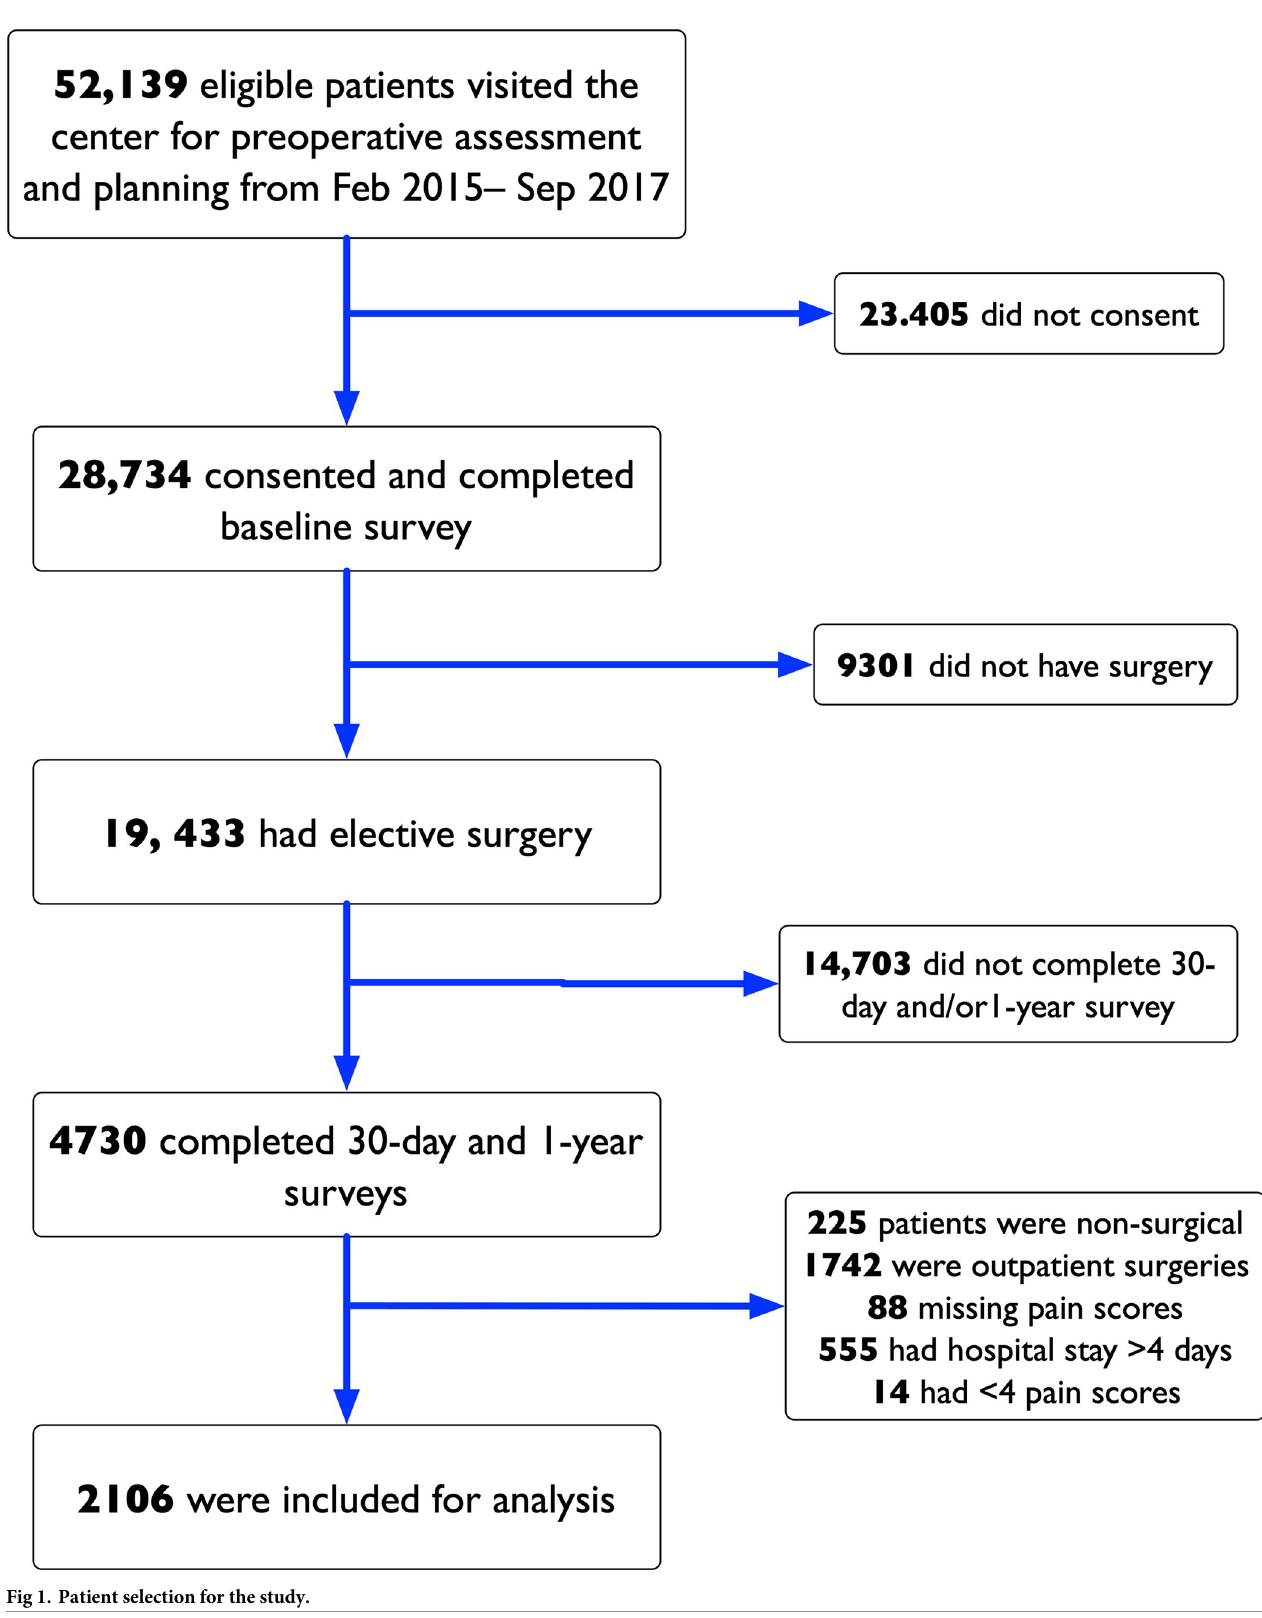
Fig 1. Patient selection for the study.